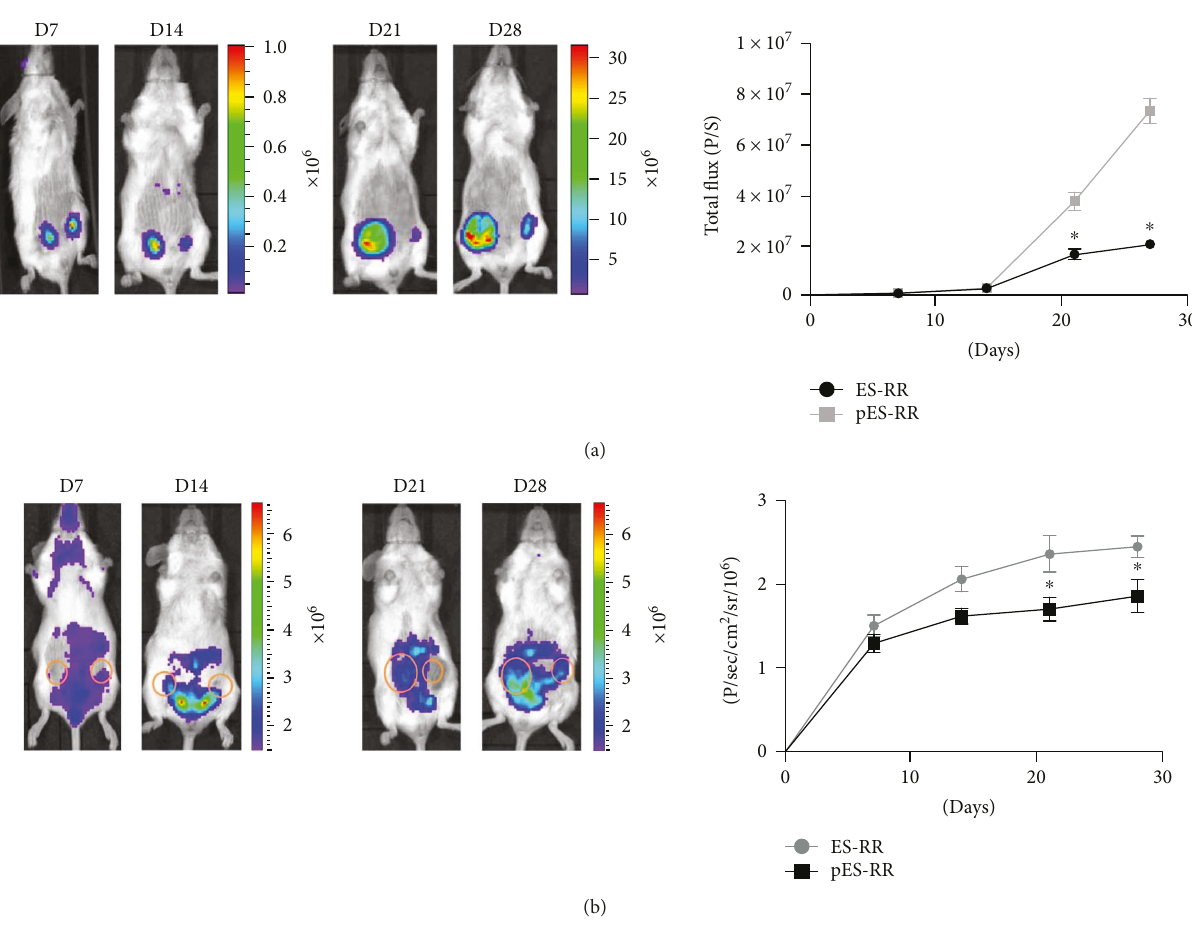
Figure 3: Visualization of the teratoma growth and VEGFR2 expression in vivo . (a) Rluc imaging of teratoma progression of Rluc signals showed that the teratoma formed in pES-RR group was smaller than that in ES-RR group. Quanti fi cation analysis demonstrated there was a signi fi cant di ff erence between the two groups. (b) Fluc imaging and quanti fi cation analysis of VEGFR2 expression in transgenic mice revealed enhanced angiogenesis in ES cell-derived teratomas. ∗ P < 0 05 compared with the ES-RR